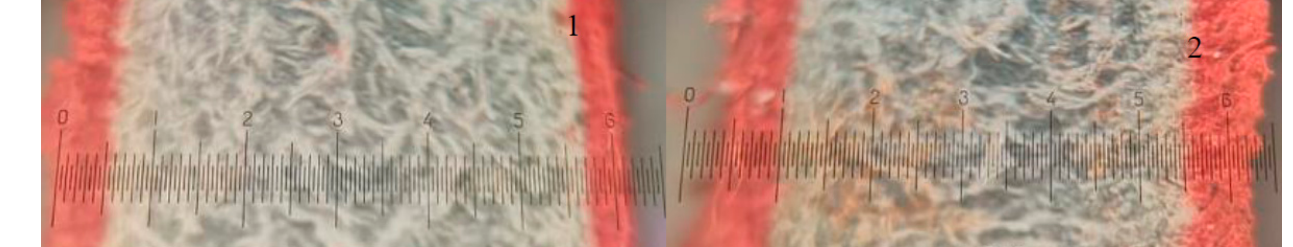
Table 3. Influence of pickling method on post-tanning processes and crust leather properties.